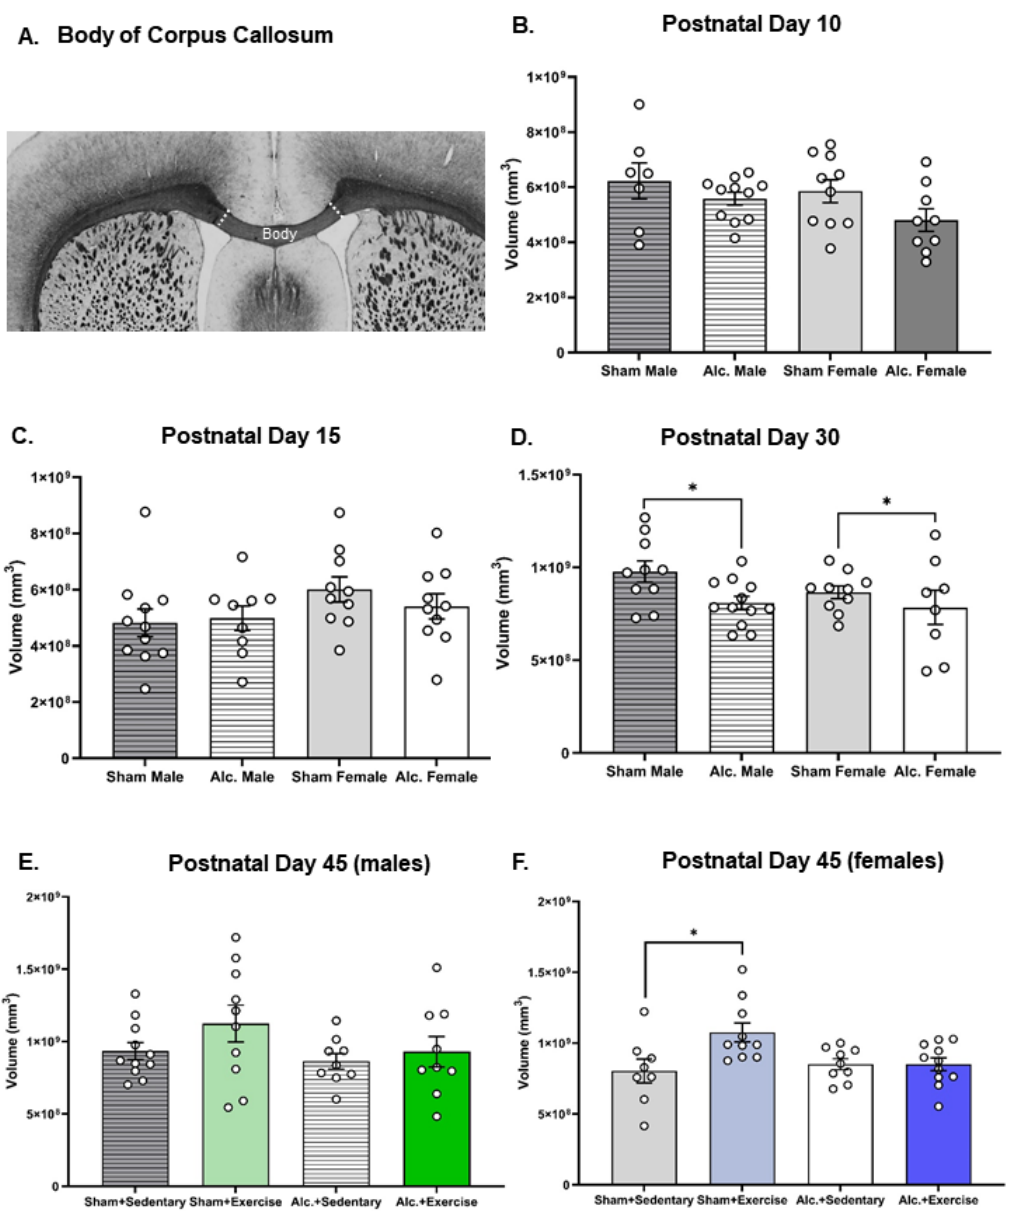
Figure 6. Volumetric analysis of the body of CC in all treatment and intervention groups from PD 10 to 45: ( A ) Macroscopic image of the body of CC, scale bar = 1 mm; ( B – D ) graphs illustrating the estimates of the volume of the body of CC for all groups on PD 10 ( B ), 15 ( C ), and 30 (pre-intervention; ( D )); ( E , F ) graphs illustrating the estimates of the volume of the body of CC for male ( E ) and female ( F ) rats on PD 45 (post-intervention). Each data point represents the mean estimate per rat and error bars represent ±SEM. * p ≤ 0.05.